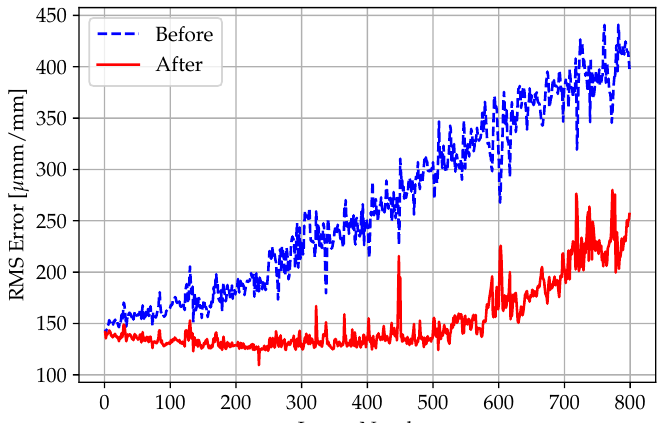
Figure 11. The RMS strain error between the stereo-DIC and 2D-DIC measurements, before and after the error compensation was applied, for Test